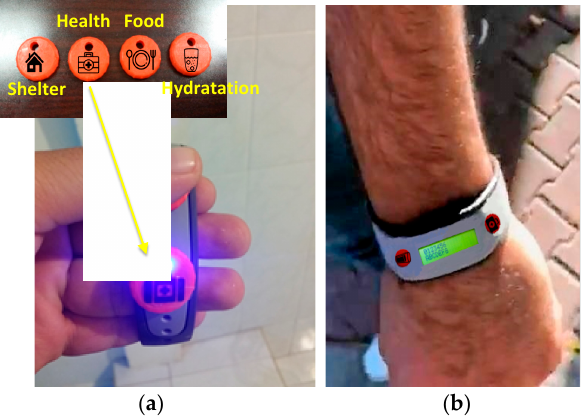
Figure 2. Digital bracelet prototype: ( a ) health digital pin highlighted; ( b ) display showing information about the assistance